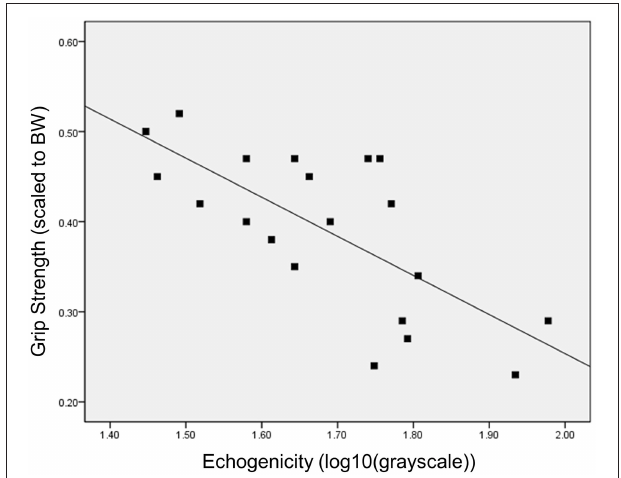
FIGURE 1 | Bivariate relationship between grip strength and muscle echogenicity. The scatterplot depicts the inverse relationship between grip strength (peak force scaled to body weight) and muscle quality as measured via grayscale histogram analysis of the rectus femoris echogenicity.